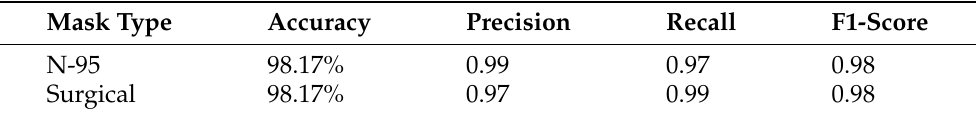
Figure 19. Confusion matrix of two models for face mask type identification and classification. Table 10. Statistics using VGG-16 for types of face masks detection and